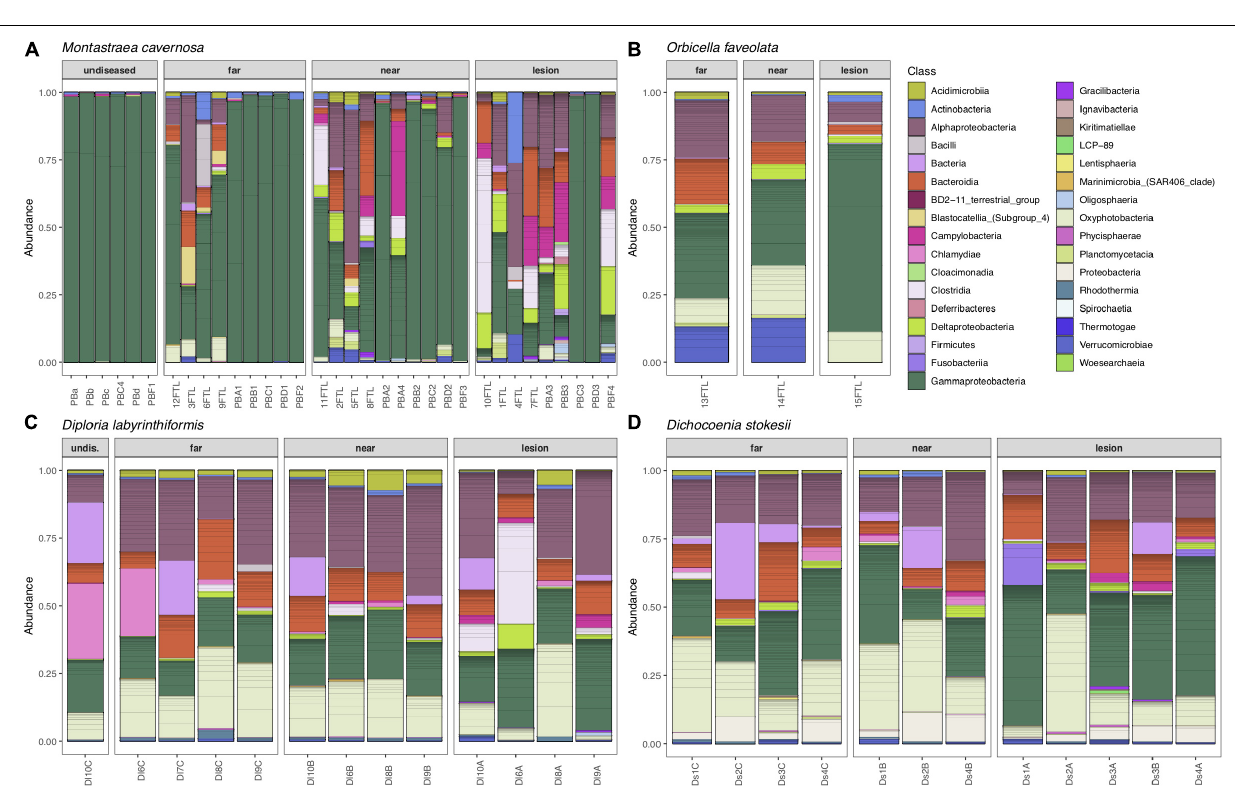
Proteobacteria by the SILVA taxonomic assignment in D.